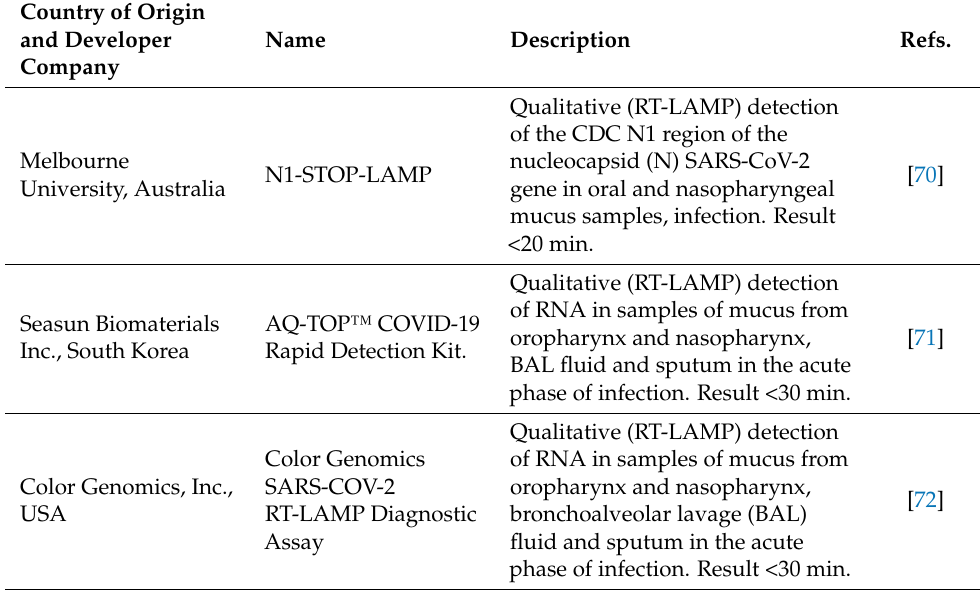
Table 3. Examples of commercial LAMP test systems (RT-LAMP) approved for SARS-CoV-2 detec-